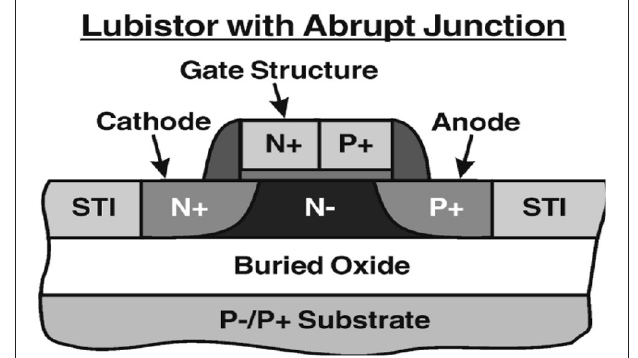
FIGURE 13 | Silicon Germanium (SiGe) 45 GHz HBT device in a 0.35 µ m technology (with permission from the ESD Association).